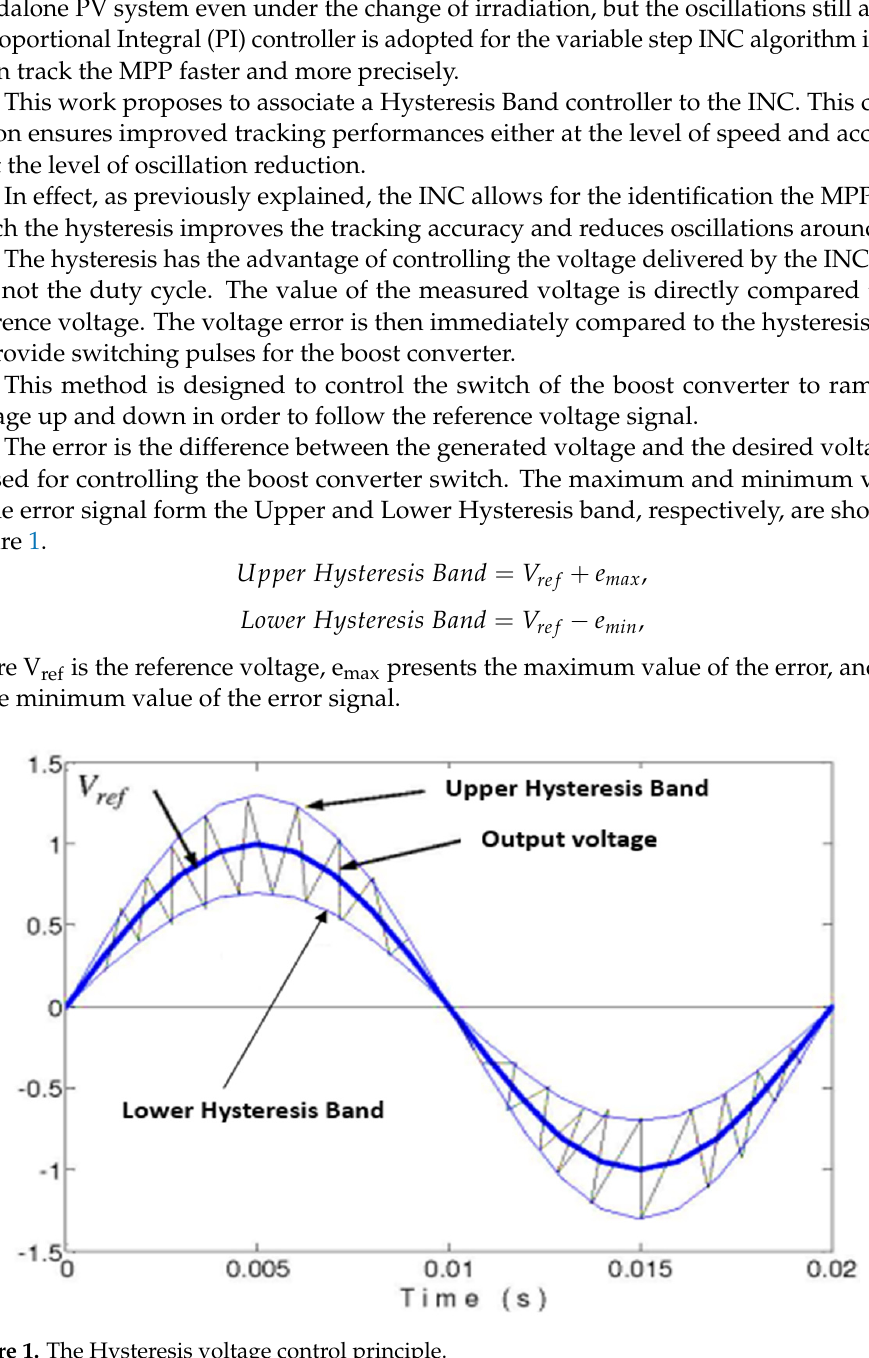
Figure 1. The Hysteresis voltage control principle. The voltage must remain between the Upper and Lower Hysteresis Band. For this reason, when the real value of the voltage attains the Upper Hysteresis Band, the switch turns ON to enforce the voltage to decrease, and when it attains the Lower Hysteresis Band, the switch turns ON to enforce the voltage to